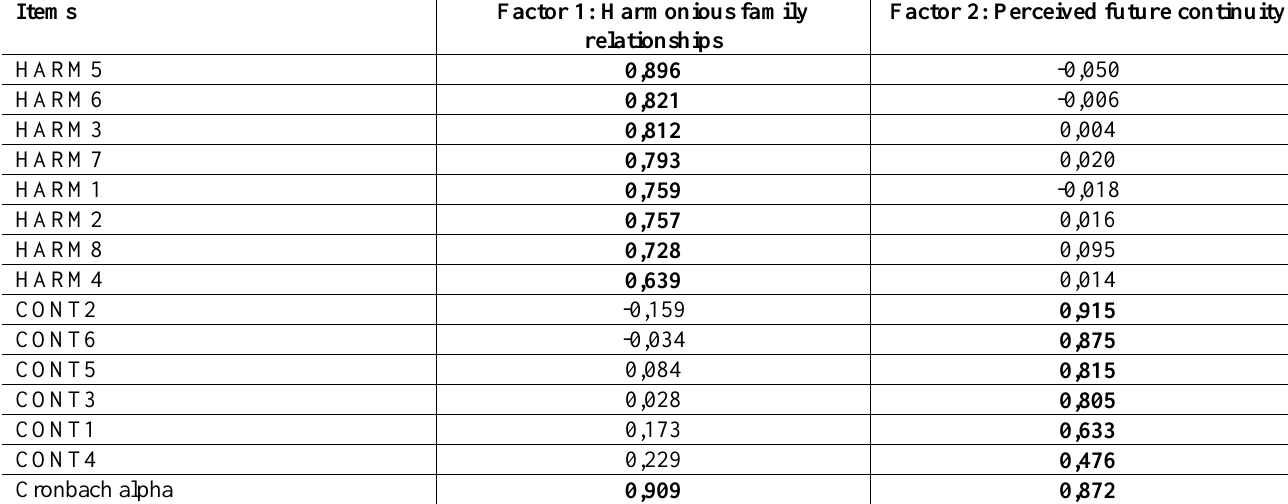
Table 1: Oblimin rotated factor matrix: Dependent variables